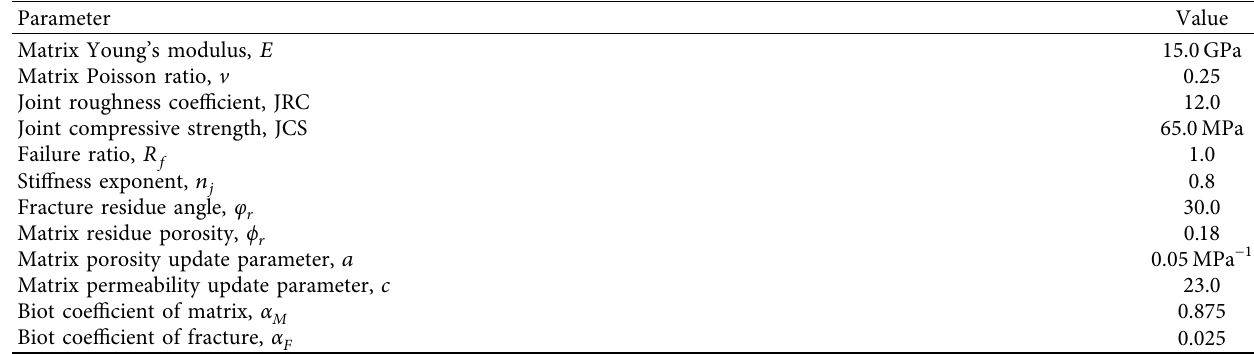
Figure 22: Capillary pressure of the rock matrix. Table 1: Mechanical